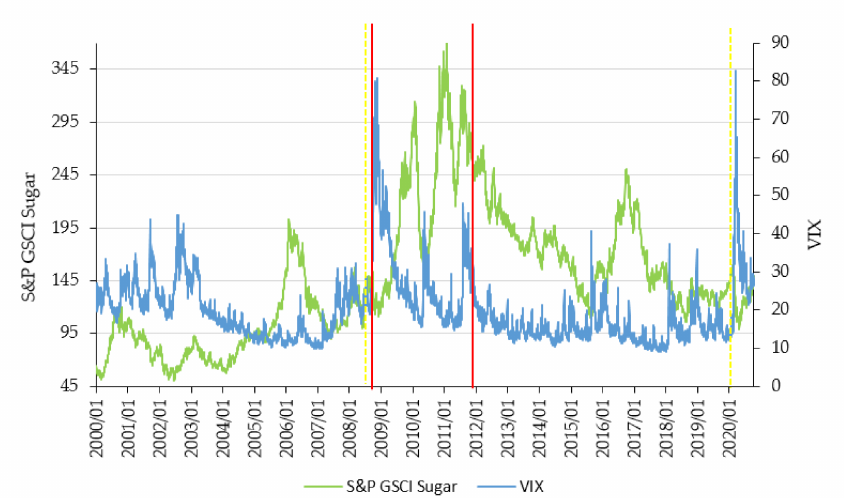
Figure 3. The S&P GSCI Sugar Index and the VIX Index between 3 January 2020–30 November 2020.